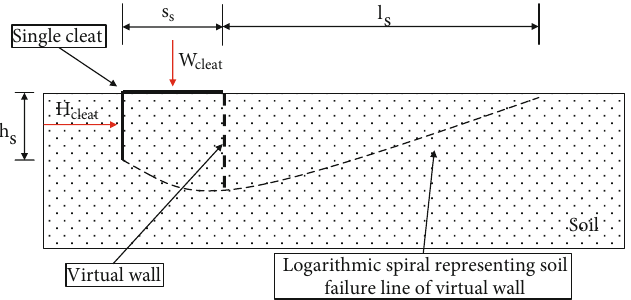
Figure 3: Description of the geometrical parameters, virtual wall, and the rupture line of a single